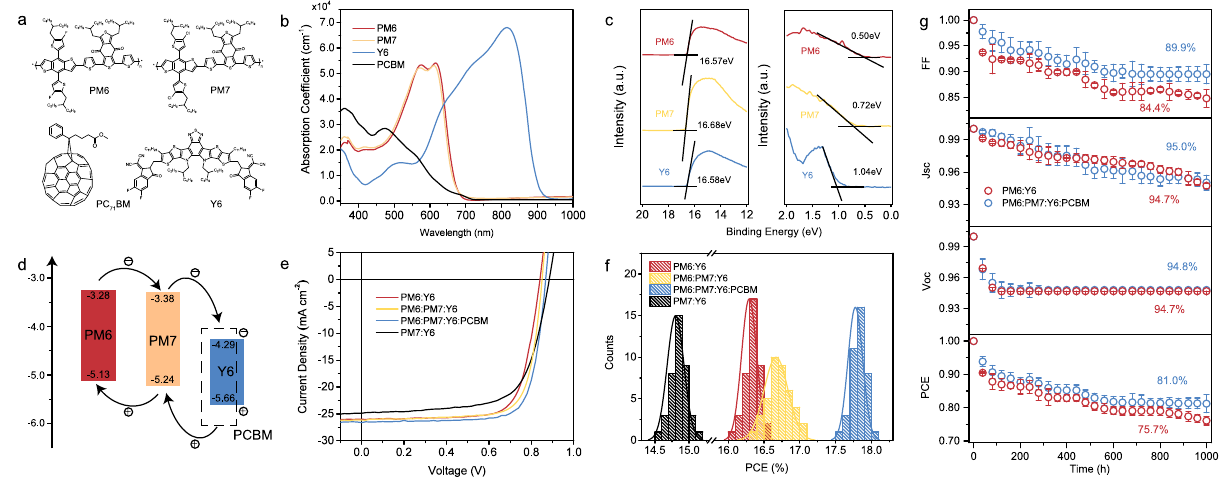
Fig. 1 Molecular structure and photovoltaic performance of single-junction devices. a Chemical structures, b thin fi lm absorption coef fi cients, and c UPS results of PM6 (red line), PM7 (yellow line), and Y6 (blue line). Fermi energy was determined by linear extrapolating the high binding energy portion of the spectrum, and HOMO energy level was referred to low binding energy onset. d Energy level alignment and double cascading transport pathways for quaternary system. e Current density – voltage characteristics and f histogram of PCE measurement for 40 devices on binary, ternary, and quaternary devices under constant incident light intensity (AM 1.5 G, 100 mW cm − 2 ). g Normalized PCE, V OC , J SC , and FF (20 devices statistics) against aging time under illumination equivalent to ~1 sun for 1000h (red for binary and blue for quaternary, the error bar is from the deviation of twenty